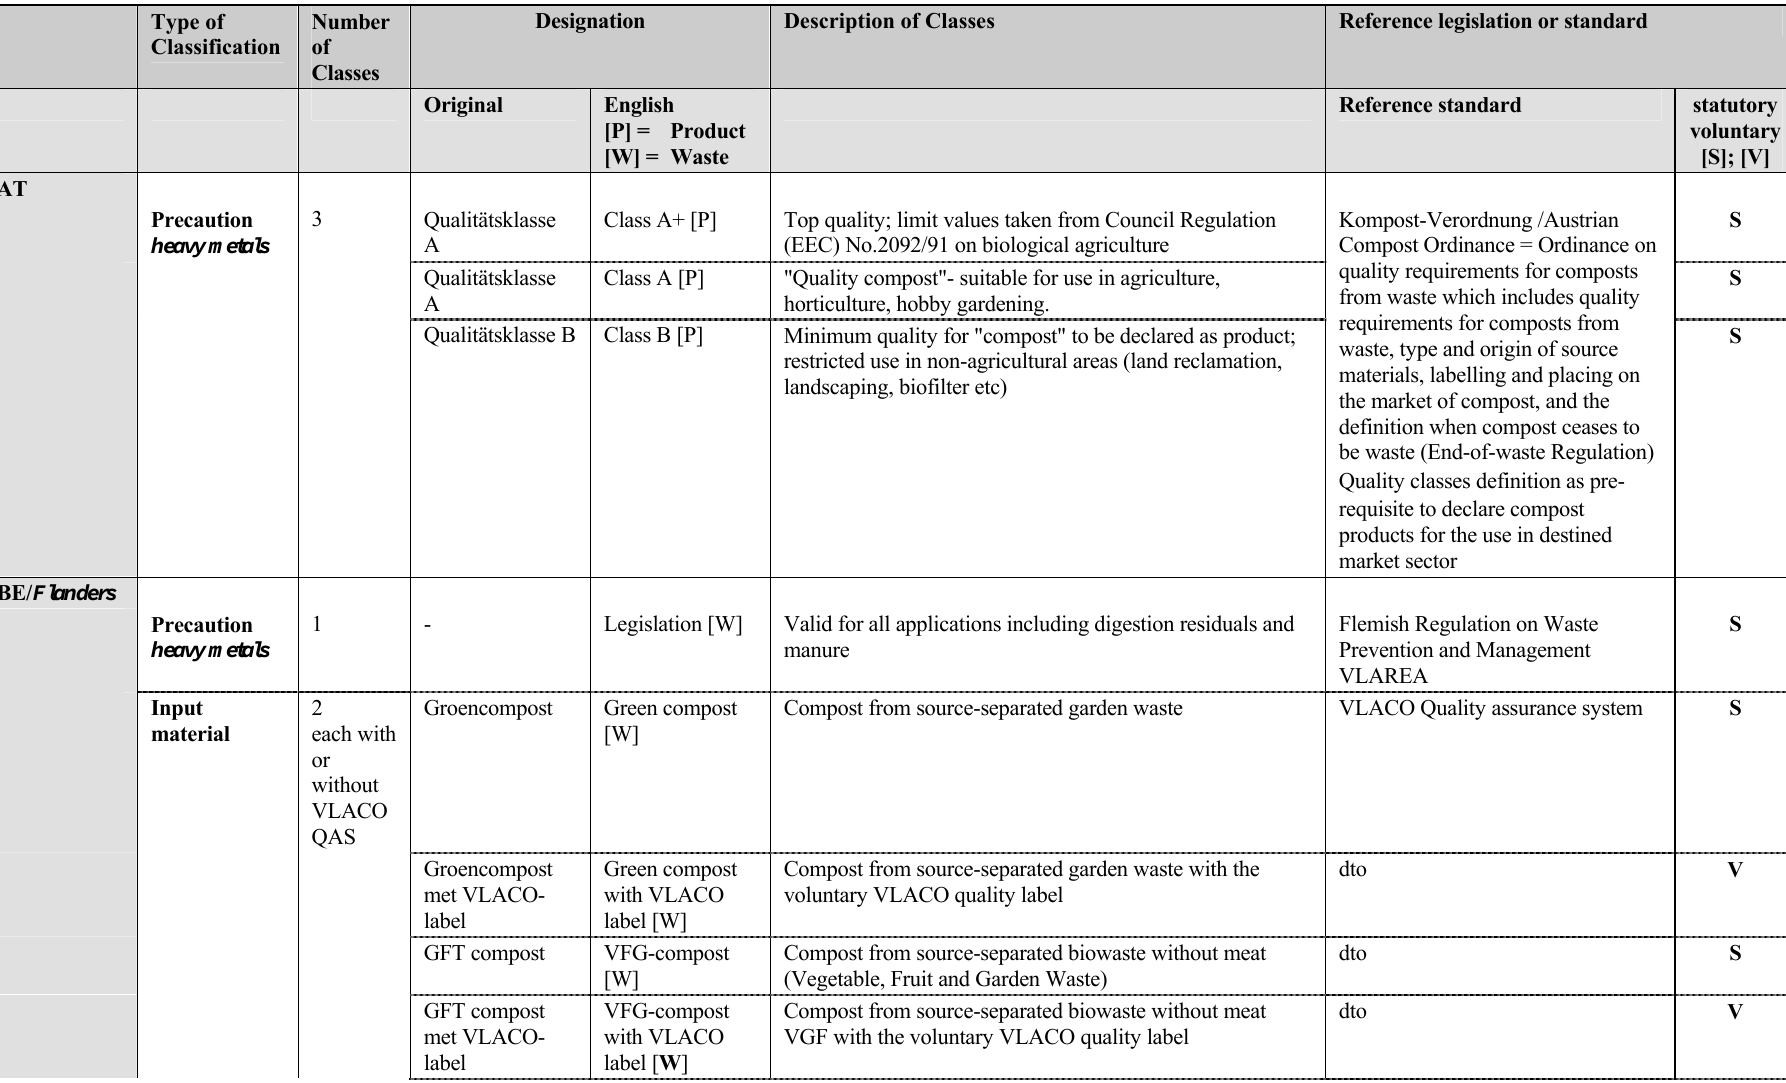
Table 3: Number of classes in compost standards,